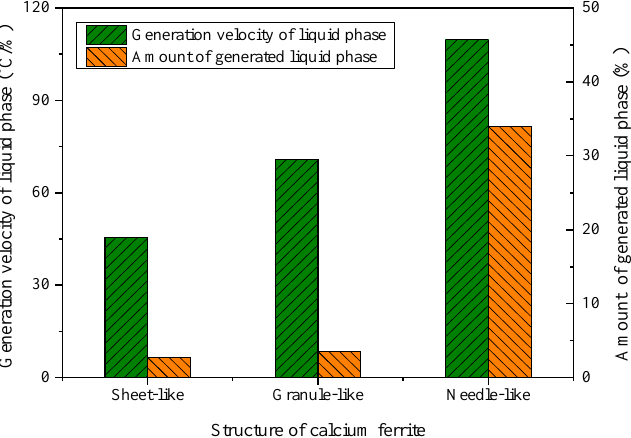
Figure 15. Relationship between the structures of SFCA and the liquid formation properties and SFCA.